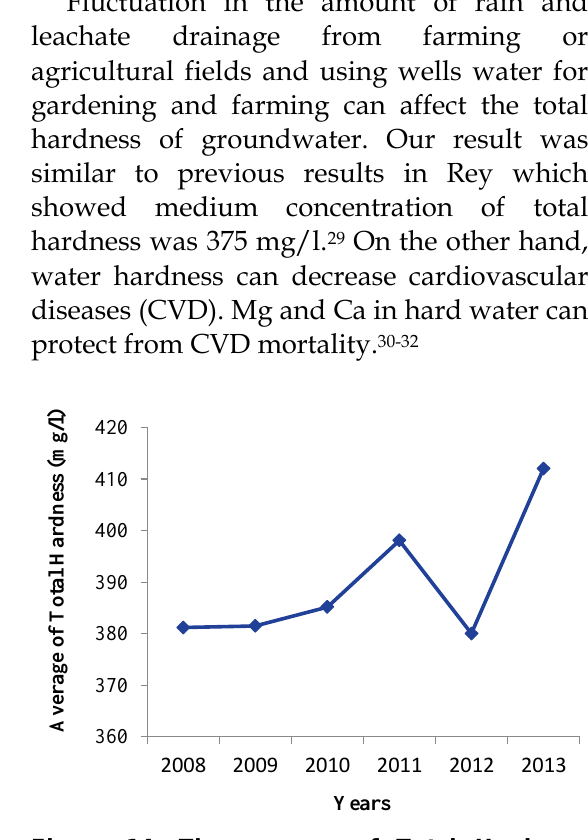
Figure 14. The average of Total Hardness (mg/l) by year